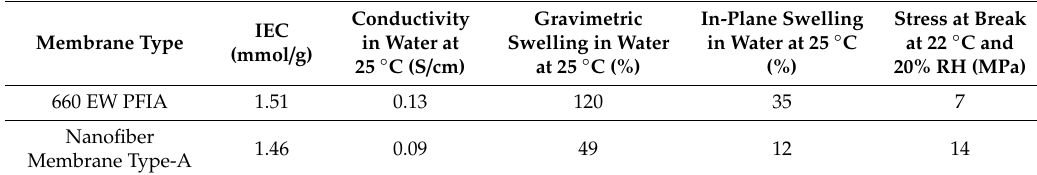
Figure 8. Comparison of in-plane proton conductivity at 80 °C versus relative humidity for hybrid nanofiber Membrane Type-A (65-15 / 20 PFSA-SiO x SO 3 H / PVDF, with sol-gel sulfonic acid silica sites in 825 EW PFSA fibers) and a 660 EW PFIA solution-cast membrane. Table 6. Comparison of key properties of a solution cast 660 EW PFIA film and a nanofiber composite Type-A membrane (with sulfonated silica in the PFSA